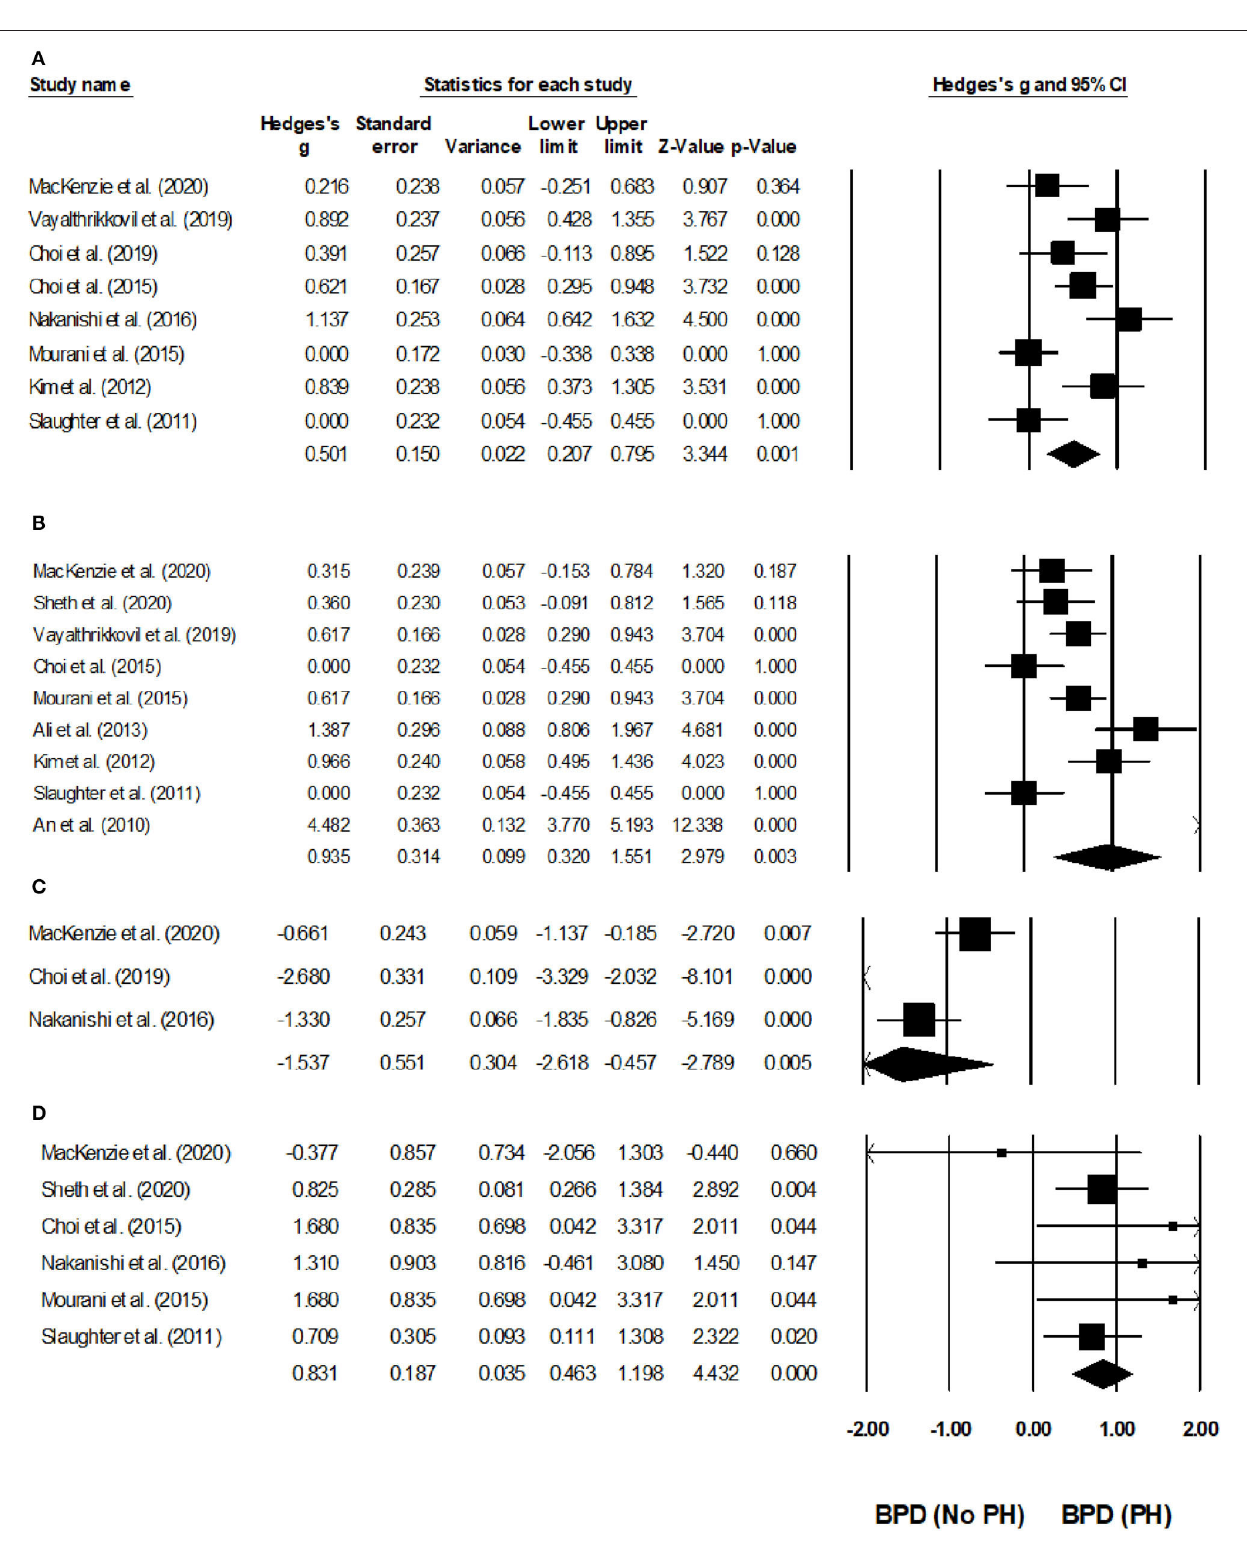
Frontiers in Pediatrics |